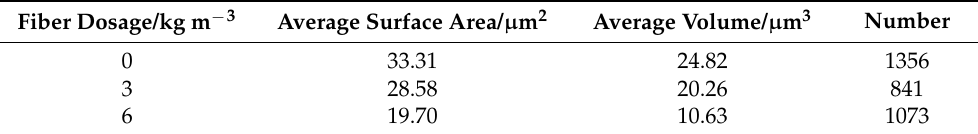
Table 2. Statistics of pore structure of BFRC specimens with different fiber dosages.